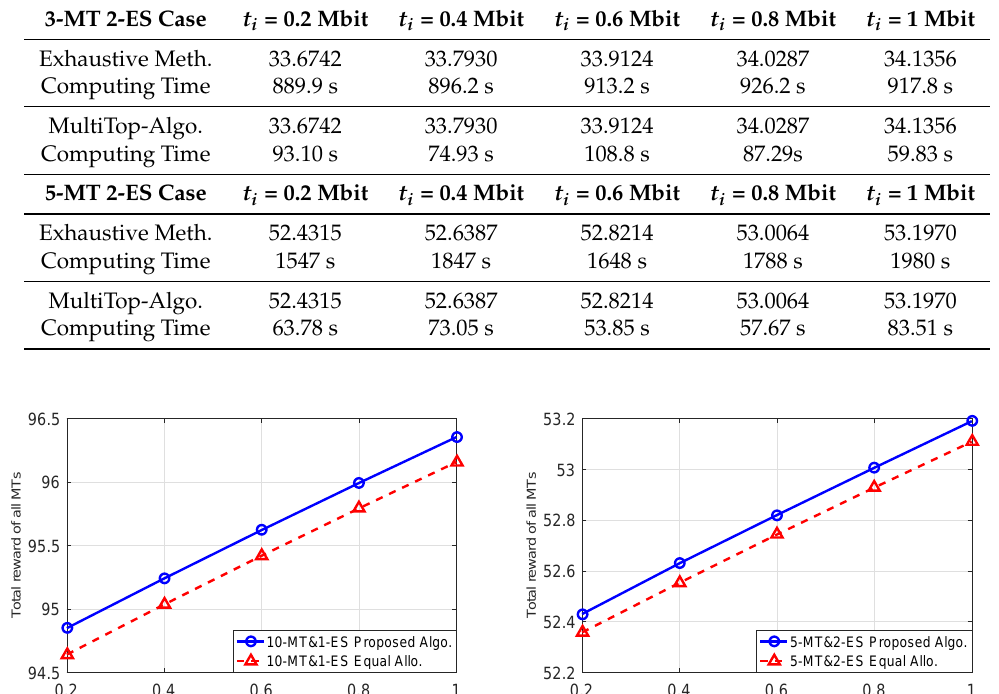
Table 3. Accuracy and efficiency of our Algorithm 6.